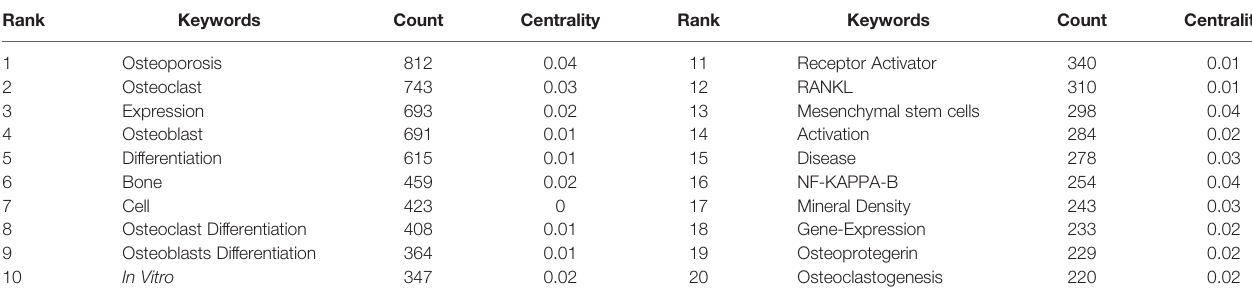
TABLE 5 | The top 20 keywords involved in osteoblasts-osteoclasts in bone disease